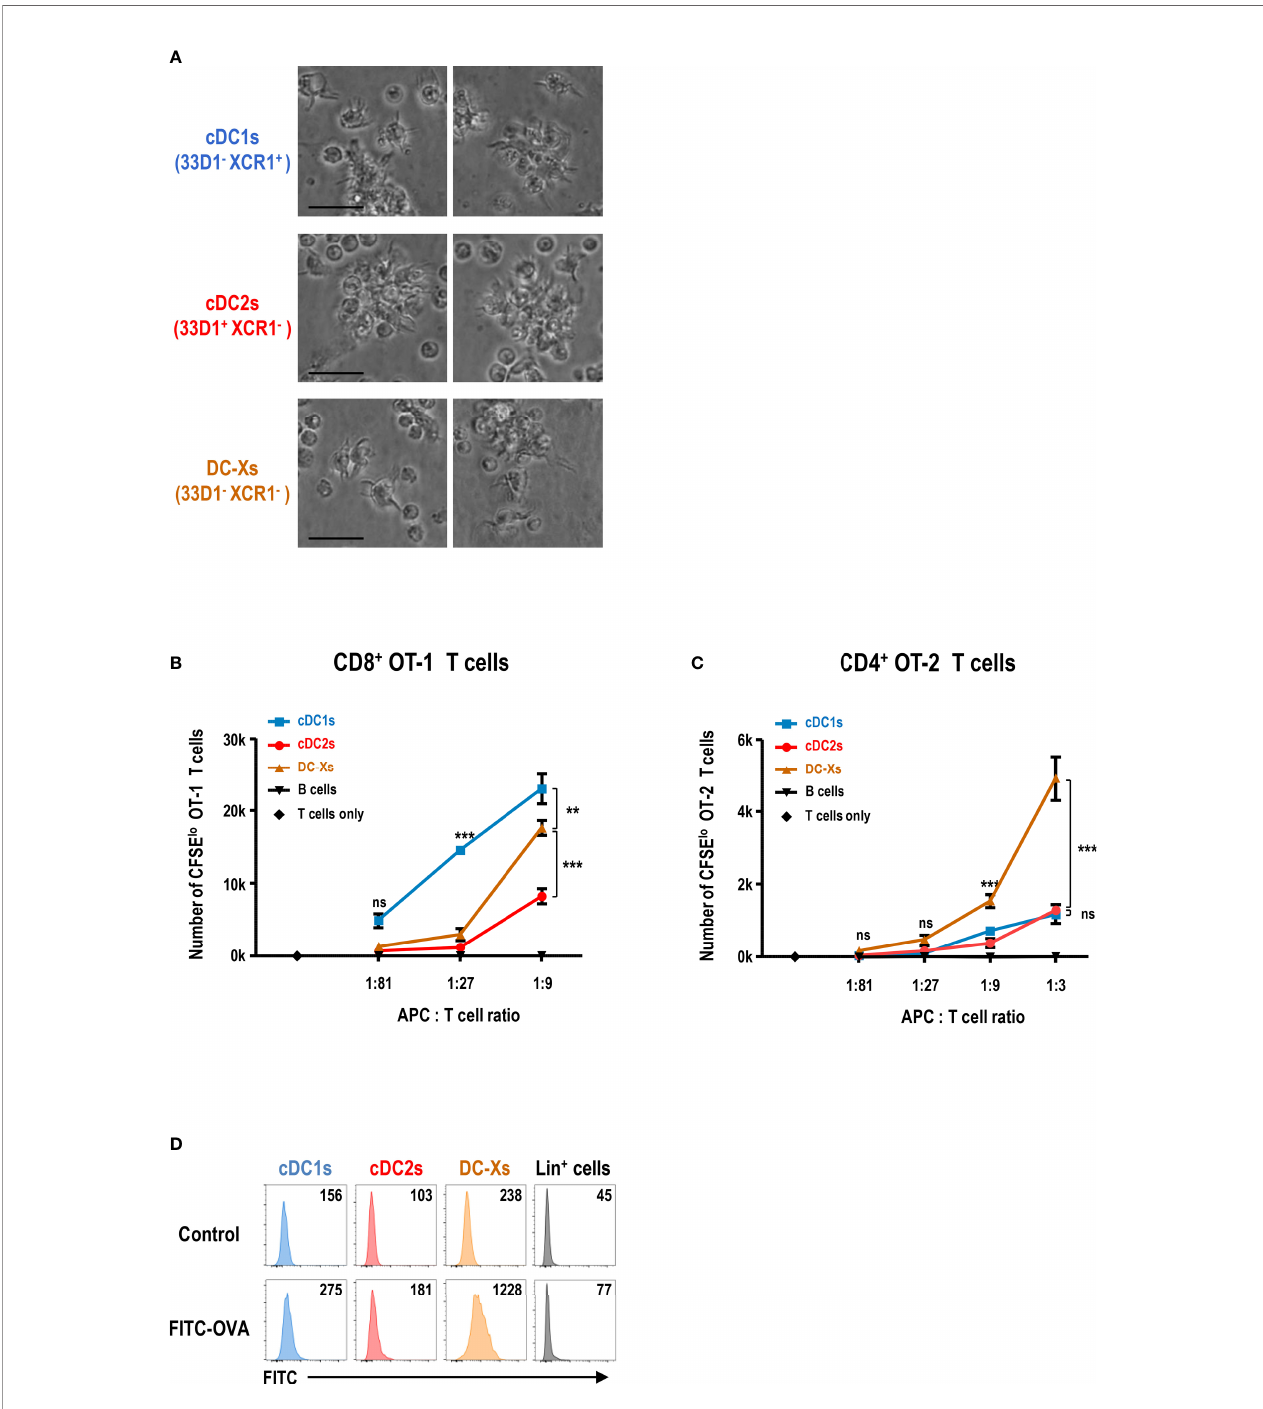
FIGURE 2 | GM-CSF-induced splenic DCs ef fi ciently stimulate CD4 + T cells in response to blood-borne antigen. (A) Morphologies of splenic DC subsets isolated from GM-CSF-treated mice and cultured overnight (magni fi cation, 400×; scale bars, 25 m m). Representative images (n = 2 mice). (B, C) Antigen presentation by splenic DC subsets and CD19 + B cells isolated from GM-CSF-treated mice at 1 hour after the intravenous injection of OVA. Proliferation of CFSE-labeled naive CD8 + OT-1 (B) and CD4 + OT-2 (C) T cells following culture with graded doses of different antigen-presenting cells (APCs). Data are shown in mean ± SEM (n = 3 or 4 replicates) from 2 (B) and 4 (C) independent experiments. (D) Uptake of blood-borne FITC-OVA by splenic DC subsets at 1 hour after the intravenous injection of control DPBS or FITC-OVA into GM-CSF-treated mice. Mean fl uorescence intensity (MFI) of FITC signal is denoted. Lin + cells include CD3 + , CD19 + , Ly6G + , and TER119 + cells. Representative fl ow cytograms (n = 3 mice for each condition). ** p ≤ 0.01; *** p ≤ 0.001; ns, not signi fi cant; two-way ANOVA test (B, C)